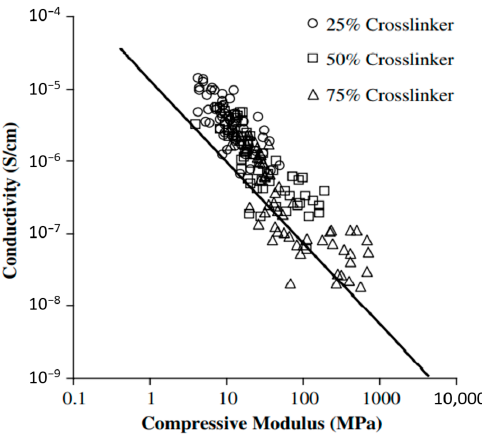
Figure 19. Conductivity vs. compressive modulus for structural polymer electrolytes investigated by Snyder et al.